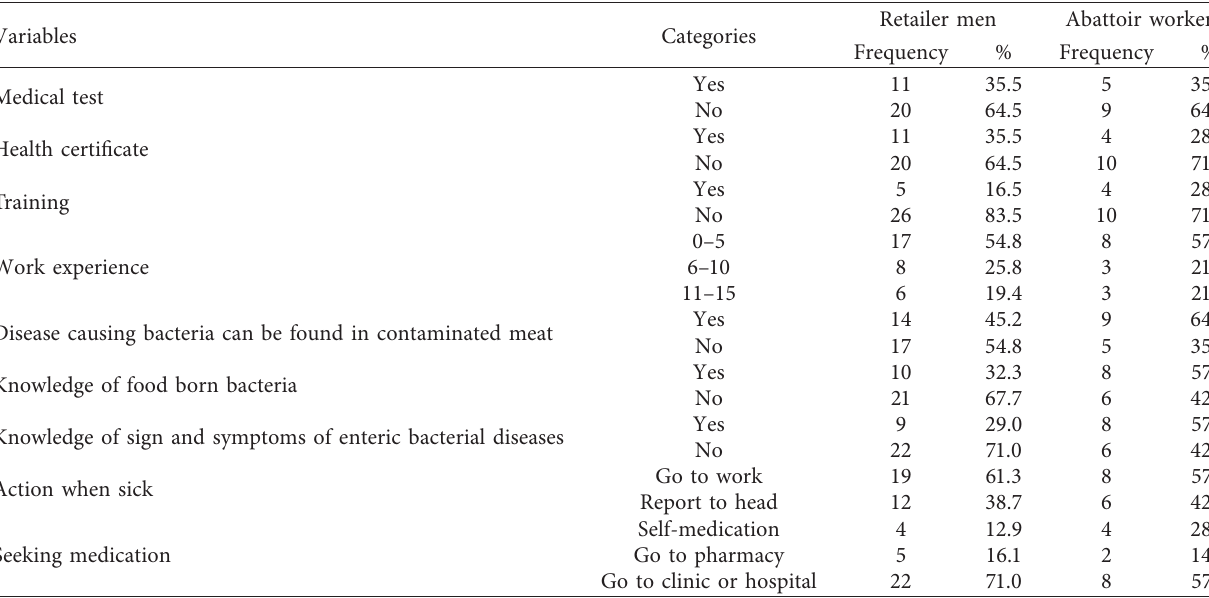
Table 3: Professional experience, training, health evaluation, and awareness about foodborne disease of retailer shop and abattoir workers in Ambo, West Shewa, Ethiopia (January 2016 to May